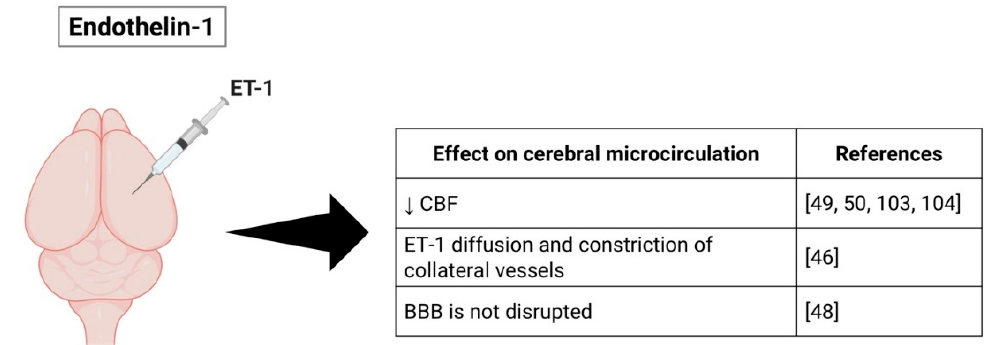
Figure 3. Schematic representation of the endothelin-1 (ET-1) stroke model and its effects on the cerebral microcirculation. Figure created with Biorender (https://biorender.com).